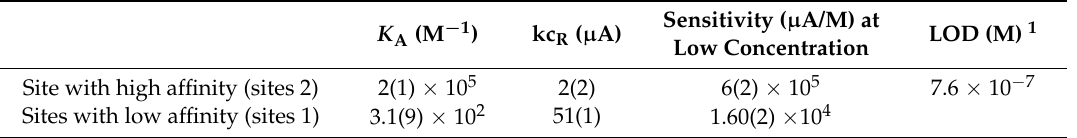
Table 1. Binding parameters of 2-FAL on MIP5 determined by the sensor SPC-MIP5 by Scatchard plot, and sensing parameters.